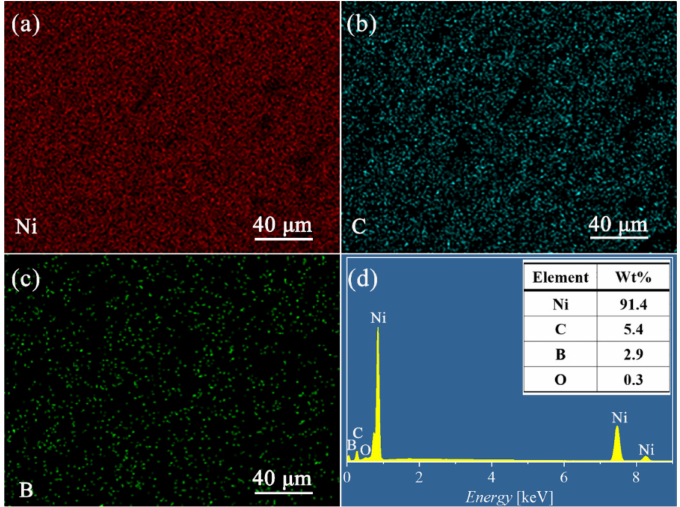
Figure 3. ( a–c ) EDS mapping and ( d ) spectra of the Ni-B-GO